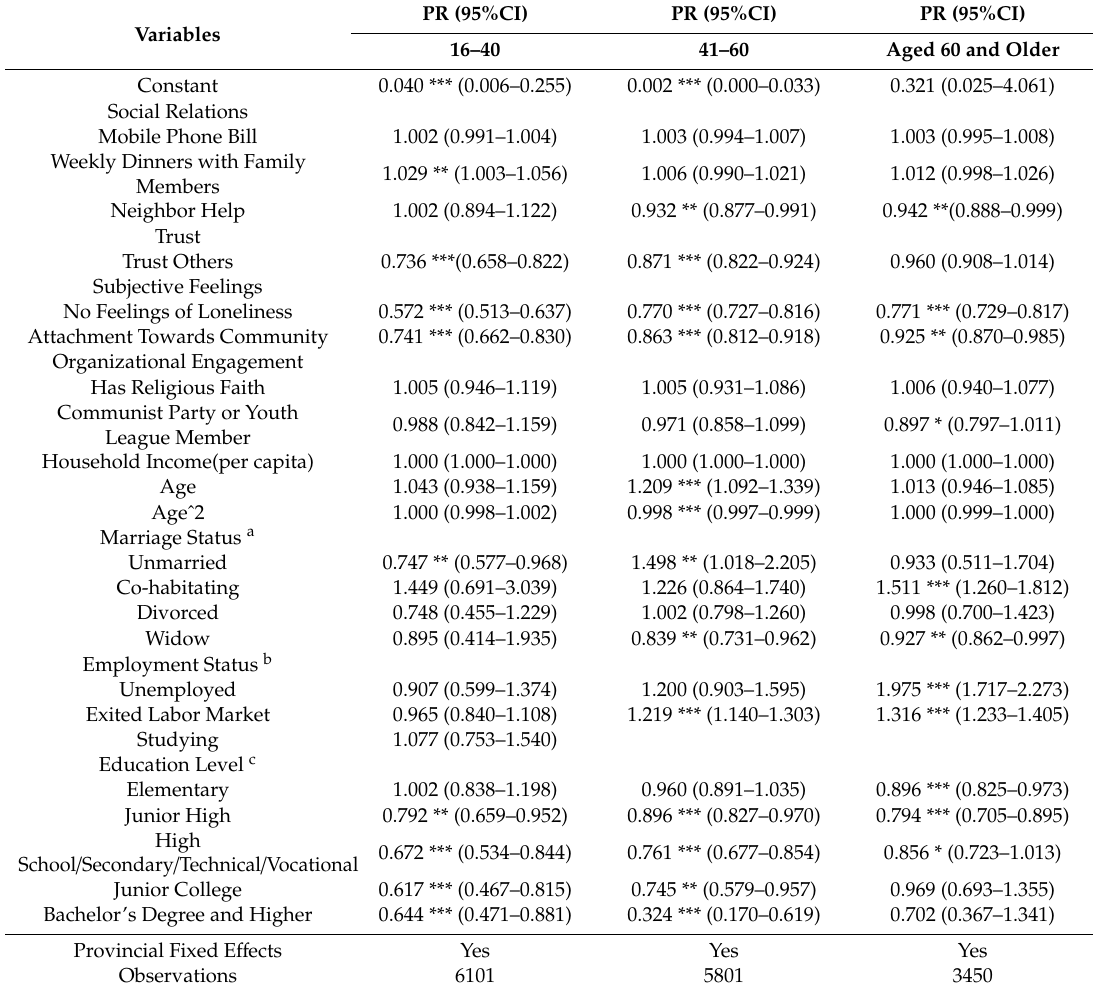
Table 3. Prevalence of reporting fair and poor health values for the women sample of di ff erent age